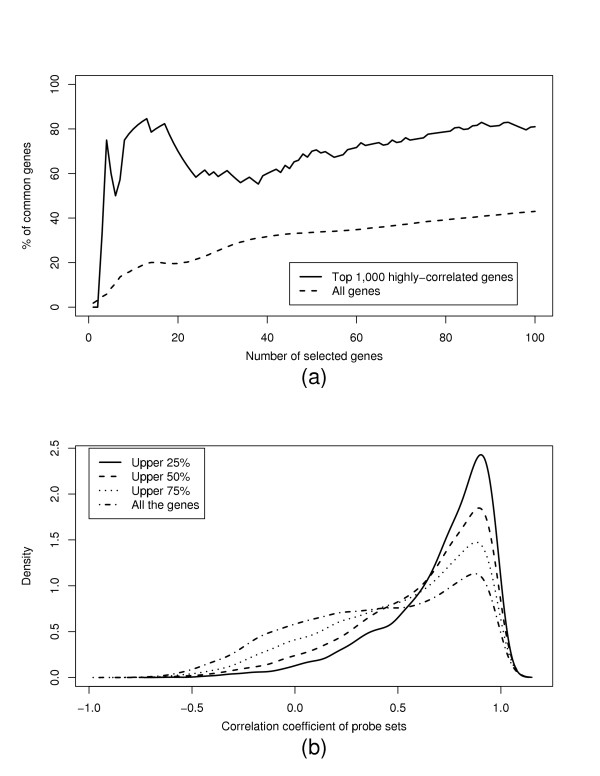
The effect of data filtering on identification of differentially expressed genes and on correlation between array types for the same genes. (a) Percentage of differentially expressed genes common in U95Av2 and U133A datasets. When we considered only the top 1,000 highly correlated genes across U95Av2 and U133A, the overlap between the lists of differentially expressed genes increased dramatically (solid line). For comparison, we show the result without gene selection by correlation (dashed line). For the latter, we subsampled a random gene set of same size repeatedly to eliminate the effect of total size; we also filtered using Present and Absent calls to increase the overlaps. (b) Distribution of the correlation coefficient of probe sets stratified by their mean expression value across U95Av2 and U133A. The density was estimated for upper quartiles using a Gaussian kernel. Filtering by expression values clearly enhances the correlation of probe sets across array types, thus improving the reproducibility in the selection of differentially expressed genes.